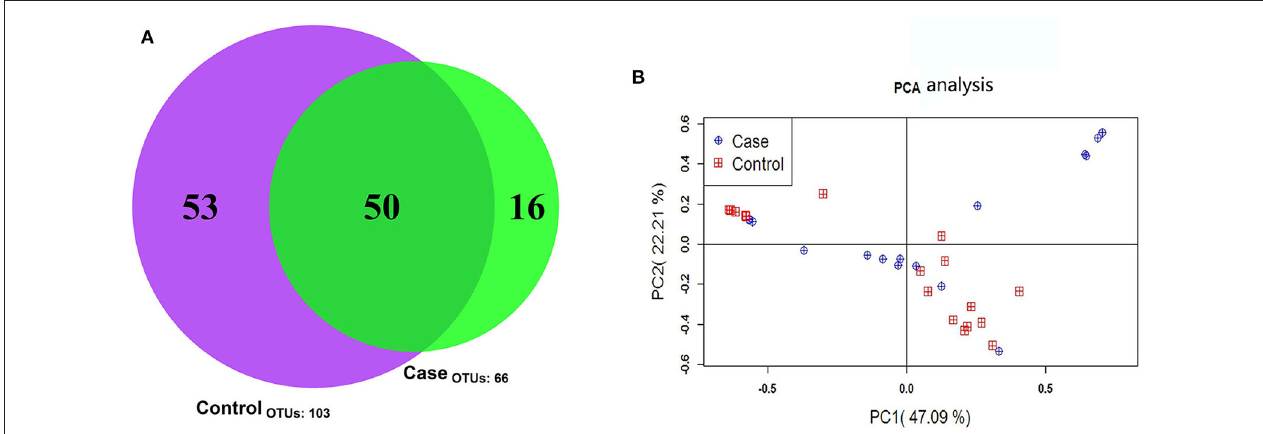
FIGURE 3 | The structure and relative abundance of the flora in the two groups at the Phylum level (A) and the genus level (B) . The structure and relative abundance in each sample at the phylum level (C) and the genus level (D) .